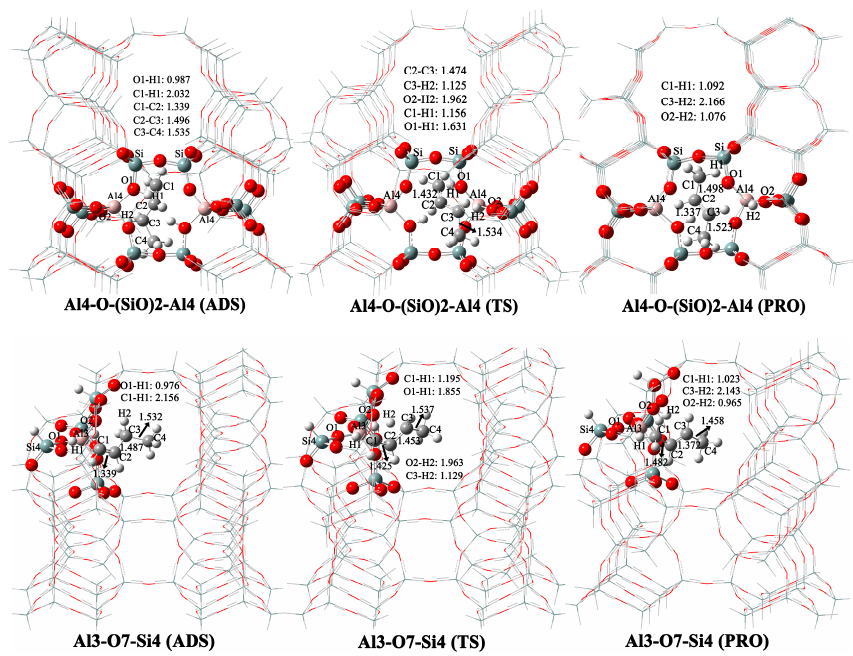
Figure 5. The optimized structures and the values of the most important geometric parameters on four active sites.